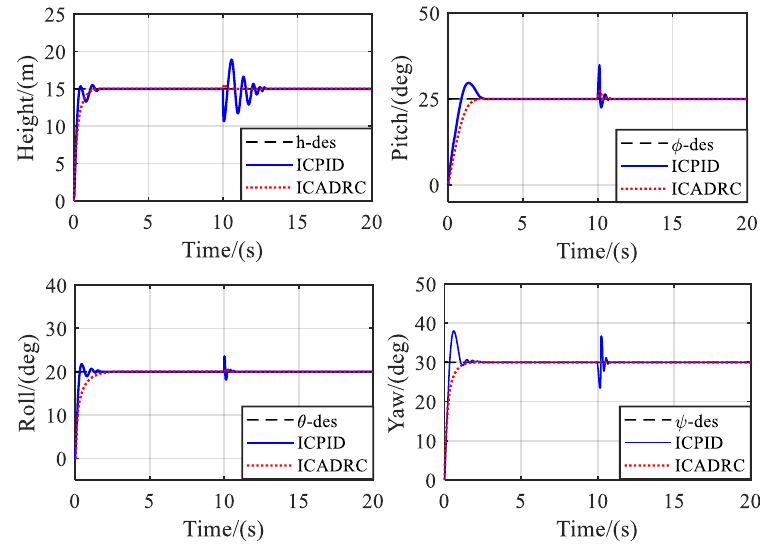
Figure 7. The responses of the quadrotor without disturbance under different controllers.